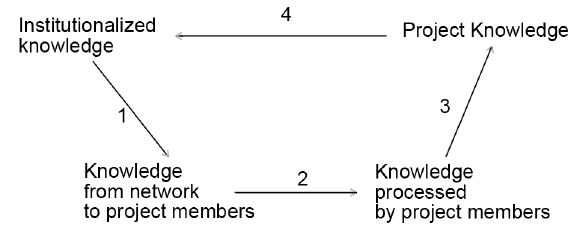
Fig. 2. A general model of project based organization’s knowledge